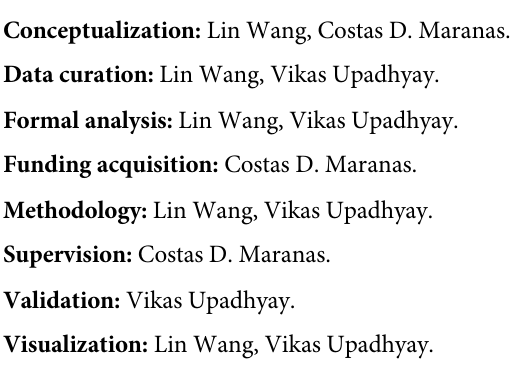
S1 Table. The list of moieties generated for bonding distance one for all the TECRDB metabolites. S2 Table. The list of moieties generated for bonding distance two for all the TECRDB metabolites. S3 Table. The list of no group change reaction in training and validation dataset and MSE and mean MAE scores for Group Contribution method. S4 Table. The list of all reactions resolved by dGPredictor from the training dataset with no-group change and corresponding experimental and estimated Gibbs energies. S5 Table. Gibbs energy information of 3603 reaction rules and their corresponding KEGG IDs. S6 Table. The list of KEGG reactions spanning unmeasured moieties S1 Fig. The architecture for multi-layer perceptron neural network. An input layer of moi- ety incidence matrix ( j x g matrix), a hidden layer with n neurons, and an output layer of esti- mates with j neurons. Here j represents the reactions, g represents the groups/moieties, and n represents the neurons in the hidden